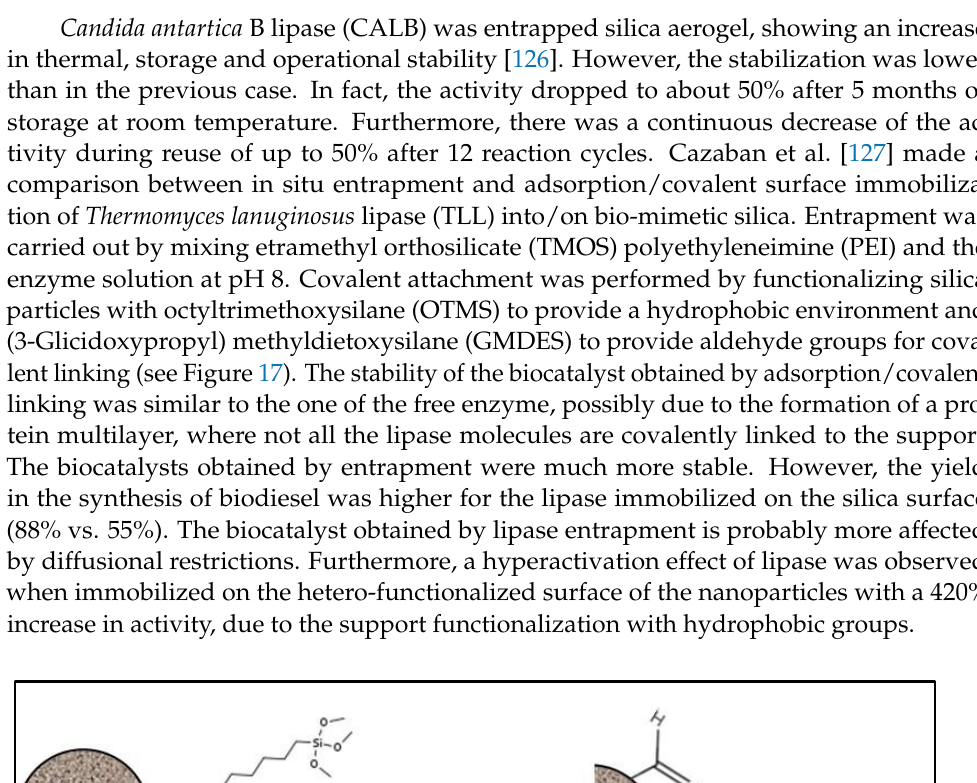
Figure 16. Scheme of lipase entrapment within mesoporous silica with an oleic acid core.